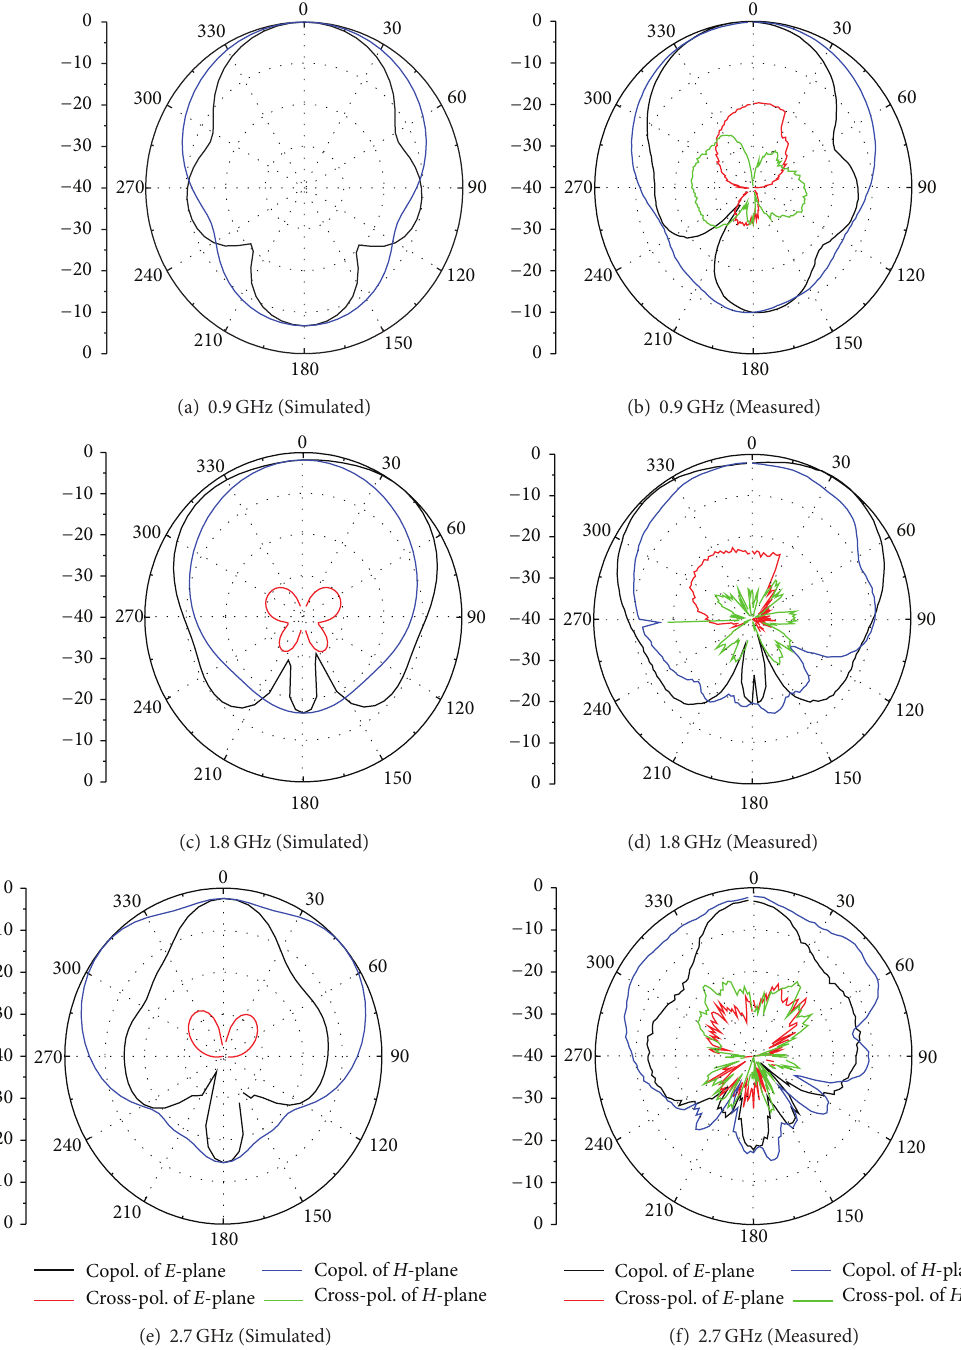
Figure 13: Simulated and measured radiation patterns at 0.9GHz, 1.8 GHz, and 2.7